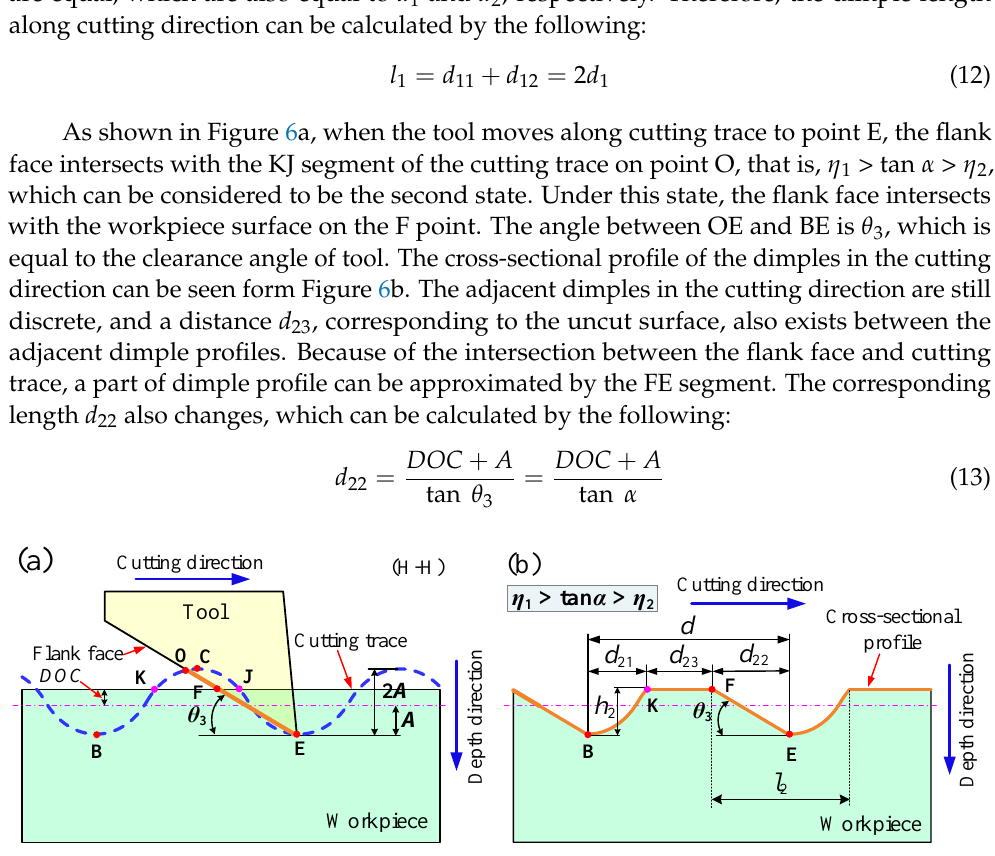
Figure 5. Flank face has no intersection with cutting trace ( η 1 < tan α ): ( a ) cutting trace; ( b ) cross- sectional profile of dimples.